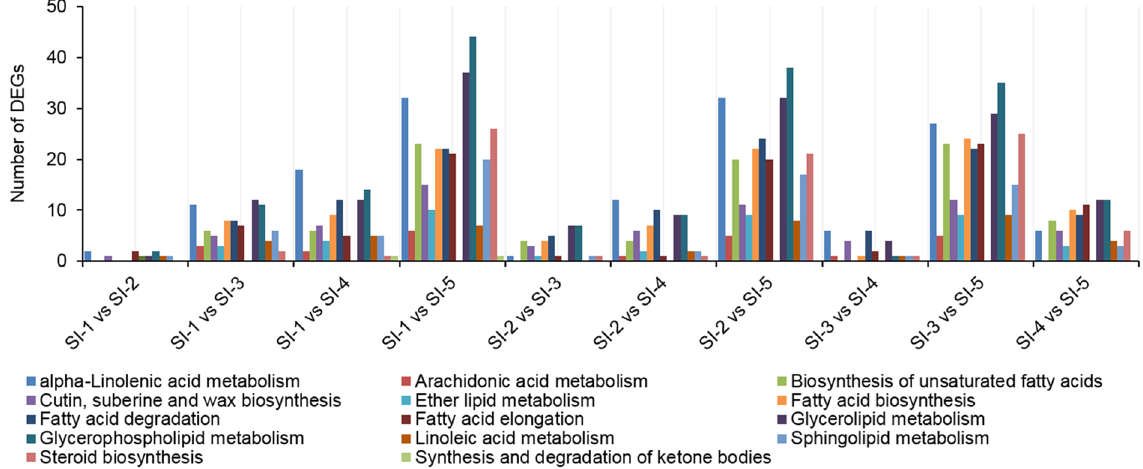
Figure 6. KEGG classification of differentially expressed lipid genes in 10 pairwise comparisons among the five seed development stages in sacha (ko04075; 357 unigenes), amino acid biosynthesis pathway (ko01230; 313 unigenes), protein processing in endo- plasmic reticulum pathway (ko04141; 308 unigenes), starch and sucrose metabolism pathway (ko00500; 284 uni-